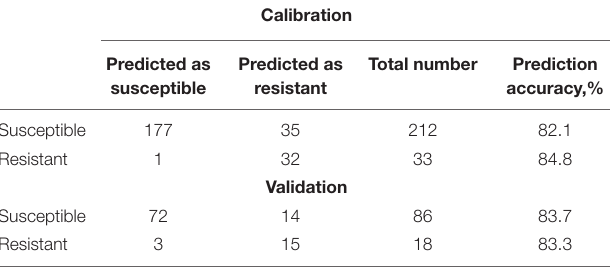
TABLE 9 | 70:30 prediction and validation model.